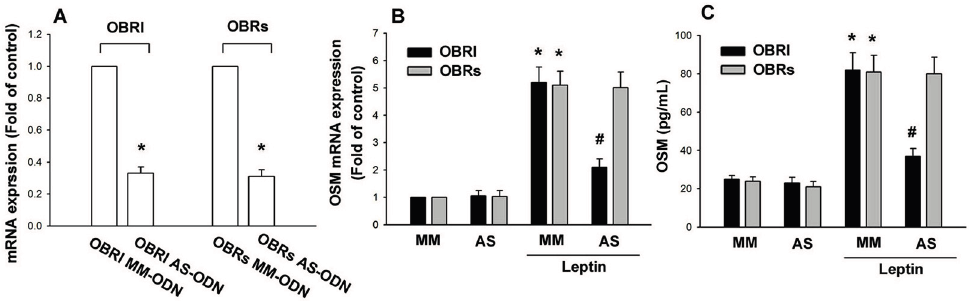
Figure 2. Leptin induces OSM expression through the OBRl receptor. ( A ) Osteoblasts were transfected with OBRl and OBRs antisense oligonucleotide (AS-ODN) or OBRl and OBRs missense (MM)-ODN, and the mRNA level of OBRl and OBRs was analyzed by qPCR ( n = 5); ( B , C ) Osteoblasts were transfected with OBRl and OBRs AS-ODN or OBRl and OBRs MM-ODN for 24 h and then stimulated with leptin (30 nM) for 24 h; OSM expression was examined by the qPCR and ELISA assay ( n = 5). Results are expressed as the mean ± SEM; * p < 0.05 as compared with the basal level; # p < 0.05 as compared with the leptin-treated